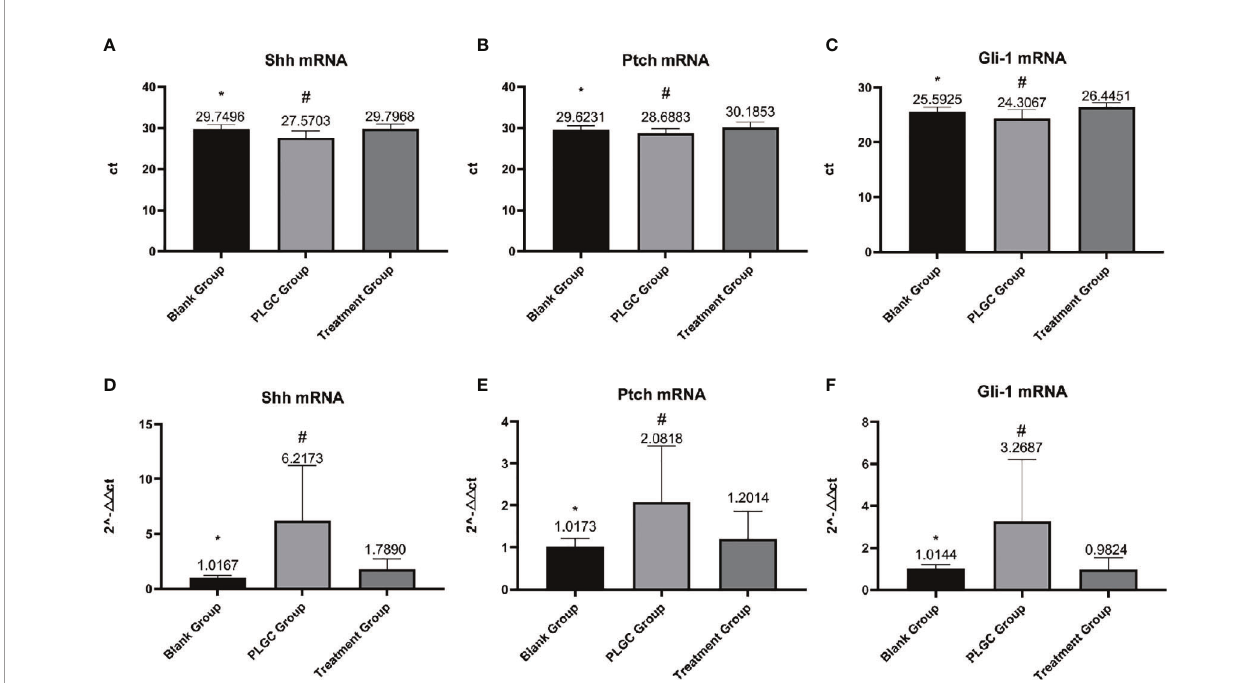
FIGURE 4 | Detection of the expression of Shh, Ptch, and Gli-1 mRNA in gastric tissue by RT-PCR. (A) Expression of Shh mRNA in each group. (B) Expression of Ptch mRNA in each group. (C) Expression of Gli-1 mRNA in each group. (D) Relative quantitative expression of Shh mRNA in each group. (E) Relative quantitative expression of Ptch mRNA in each group. (F) Relative quantitative expression of Gli-1 mRNA in each group. * P < 0.05 vs. blank; # P < 0.01 vs.